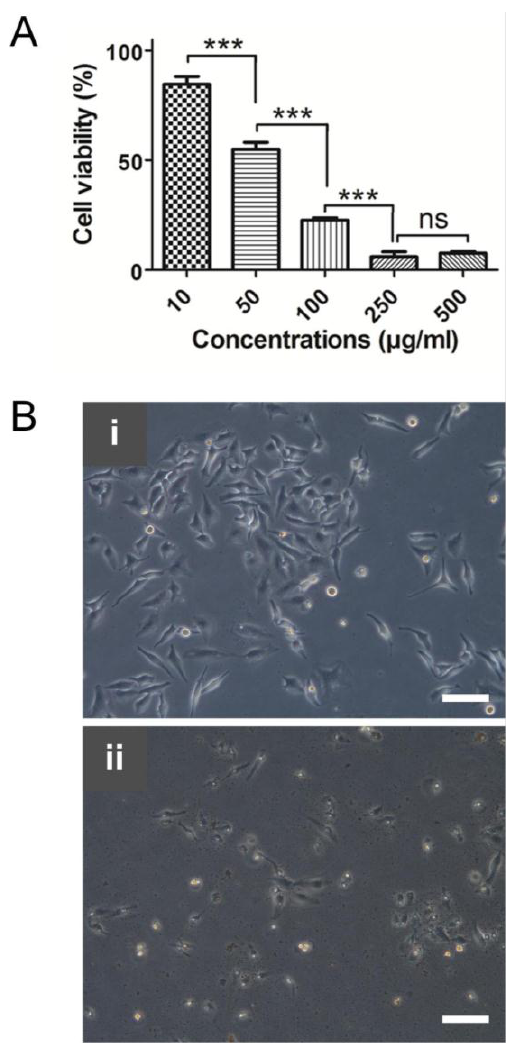
Figure 10. ( A ) Anticancer activity of biosynthesized AgNPs against HeLa cells (ns: non-significant; *** p < 0.001); and ( B ) optical microscopy images of HeLa cells after treatment with: ( i ) 250 µg/mL of Ecklonia cava extracts; and ( ii ) AgNPs. Scale bars = 100 µm.